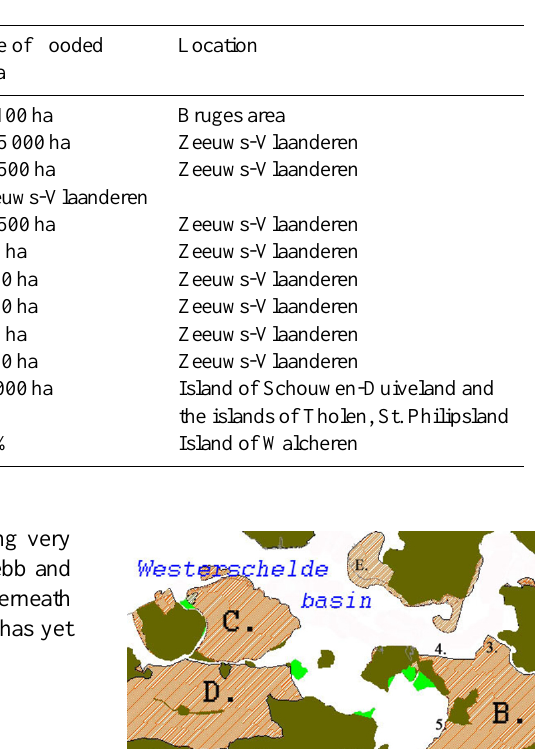
Table 2. Flooding caused during warfare in Zeeuws-Vlaanderen and elsewhere in Zeeland, 1491–1944.